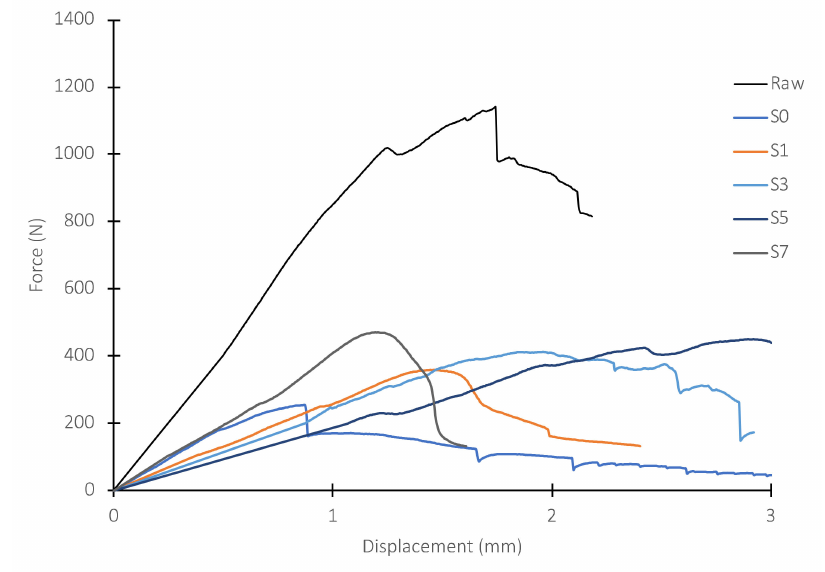
Figure 9. Iosipescu shear test curves for wet samples after 900,000 cyclic